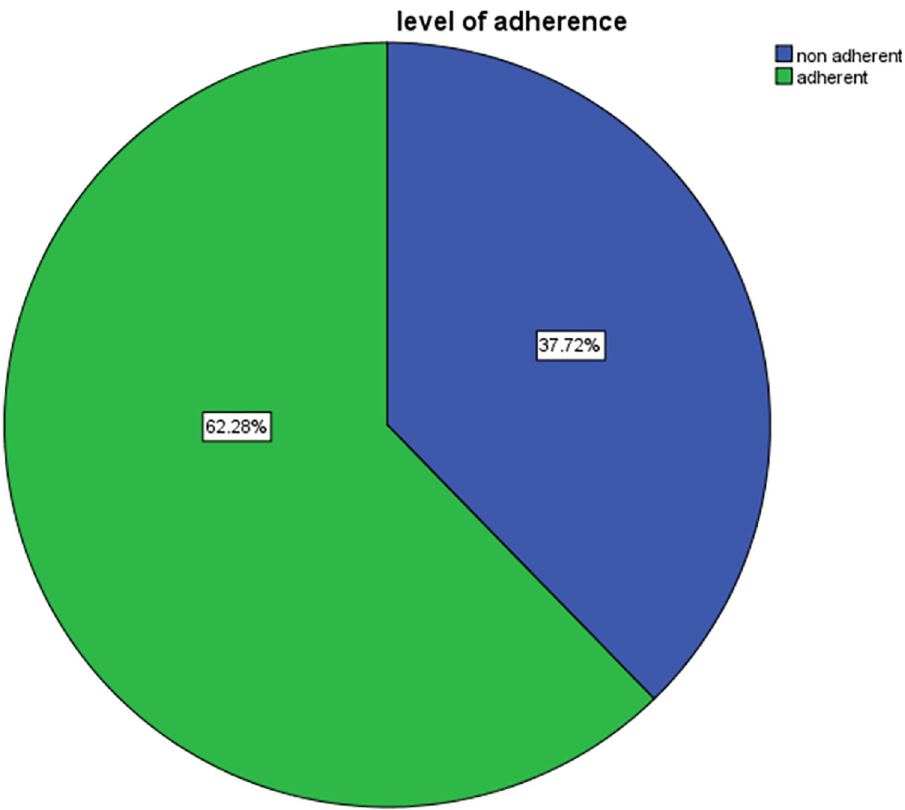
Fig 1. Prevalence of medication adherence status of respondents in Assela Referral and Teaching